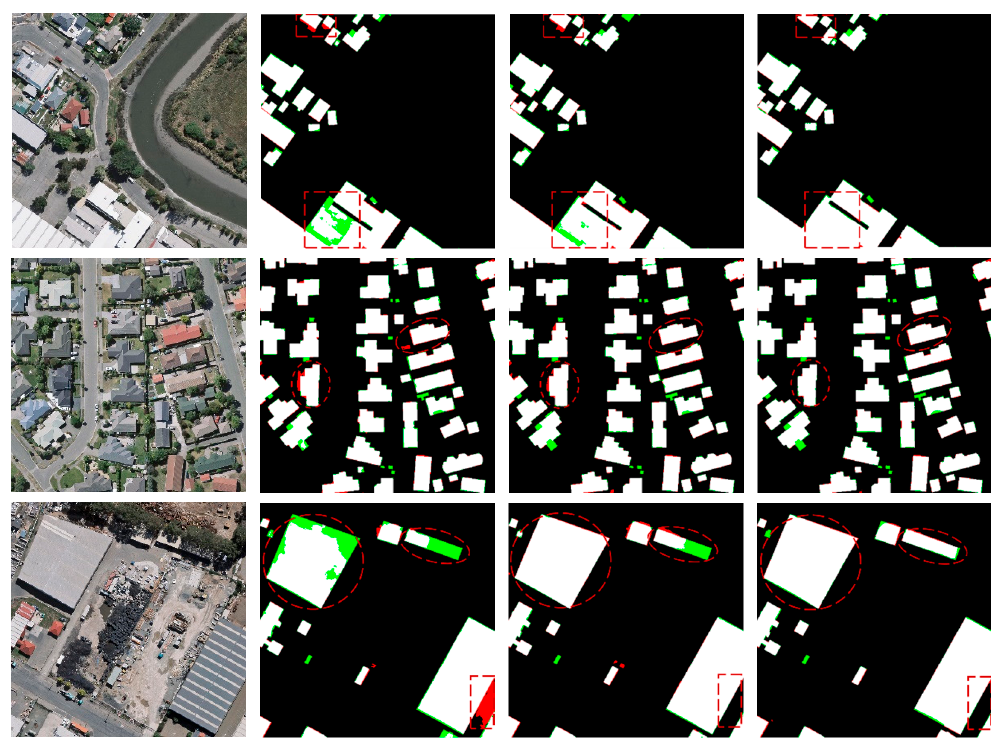
Figure 6. Comparisons for segmentation results generated from Mask-Net, DMB-Net, and the full model; i.e., DMBC-Net.